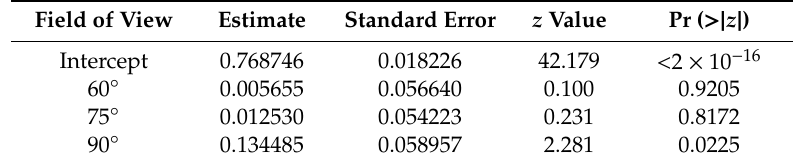
Table 3. Logistic regression analysis results of the camera field of view without the orthographic field of view.